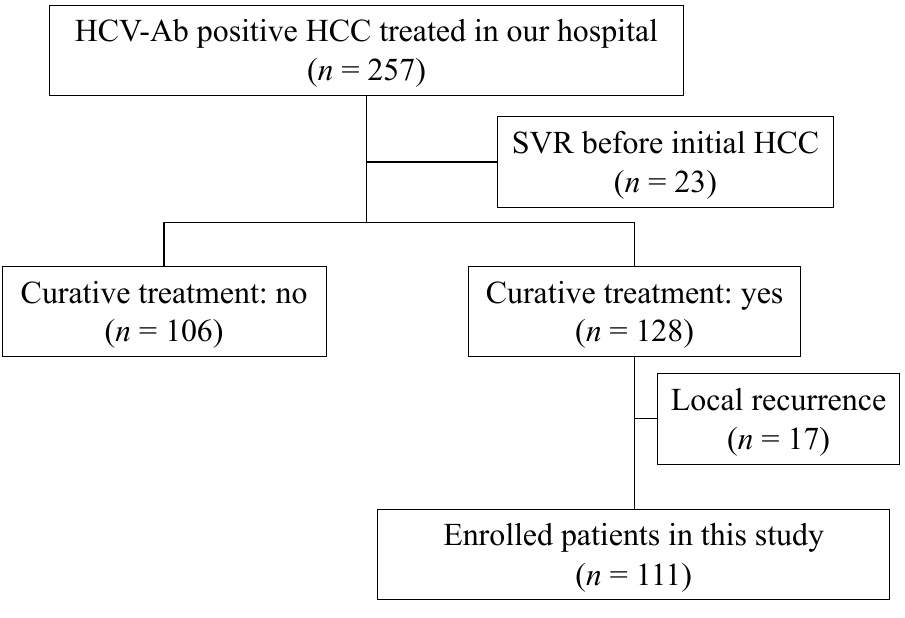
Figure 1. Patient selection flow chart.